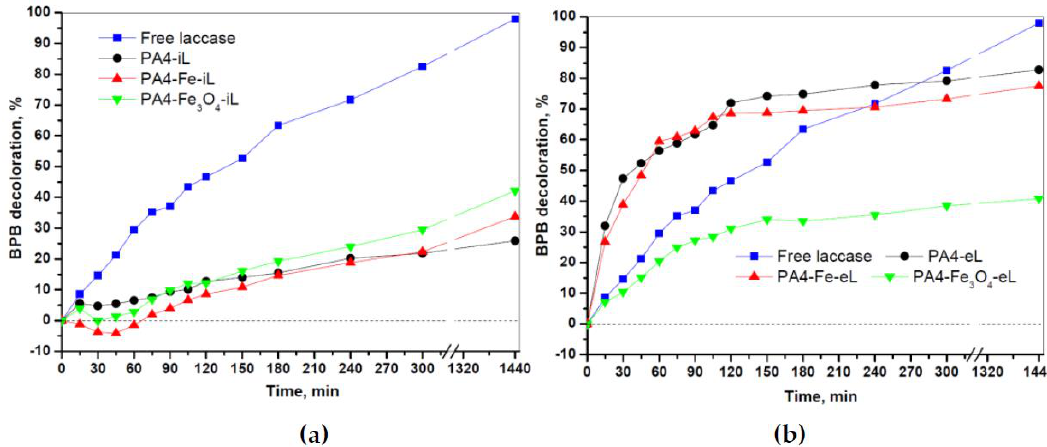
Figure 12. Decolorization of MG ( a ) and BPB ( b ) solutions by empty PA4 MP supports due to physical adsorption. The decolorization kinetics by free laccase are also given for comparison. The decolorization percentage was calculated according to Equation (5) (see Materials and Methods, Section 3.3.5.). The structures of MG and BPB are presented in Figure S4 of the Supporting Information.